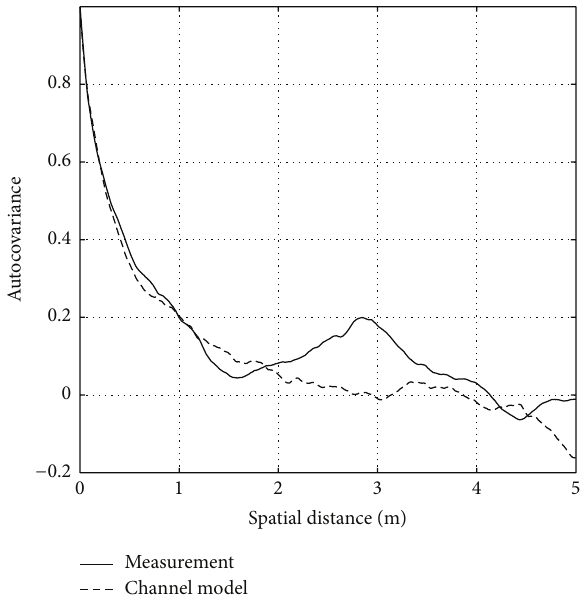
Figure 20: Spatial correlation comparison of the NLoS bias between measurementbasedestimationandchannelmodelbasedsimulation for Scenario-1.